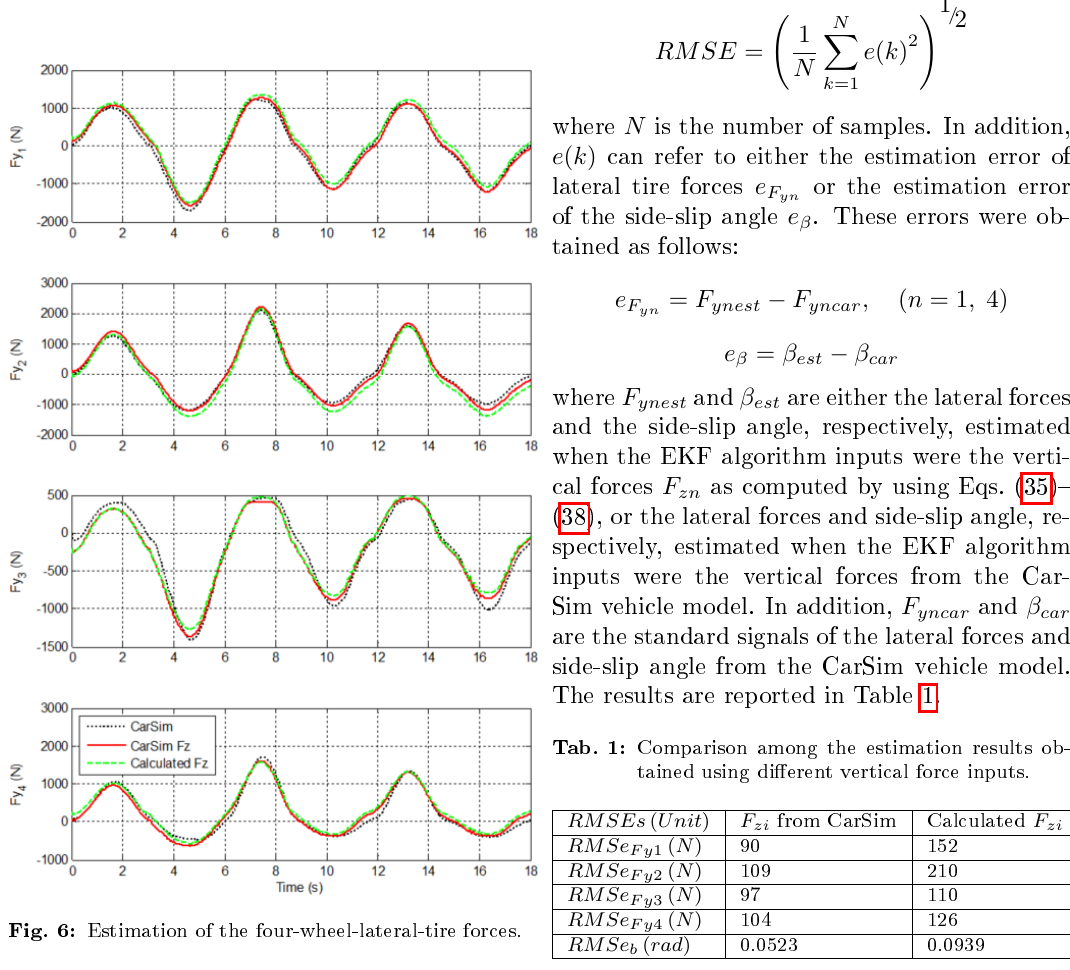
Each estimate (Figs. 6(cid:21)8) contained the out- put responses of lateral forces, lateral velocity, and the side-slip angle from the CarSim vehicle model as the standard signals for the estimator performance evaluation; lateral forces, lateral velocity, and the side-slip angle from the estima- tor when its vertical-force inputs were directly obtained from the CarSim vehicle model; and lateral forces, lateral velocity, and the side-slip angle from the estimator when its vertical-force inputs were calculated using Eqs. (35)(cid:21)(38). Be- cause di(cid:27)erences in the estimator performance levels were di(cid:30)cult to observe in Figs. 6 and 8, they were compared by calculating the RMSE values for lateral tire forces and the vehicle side-